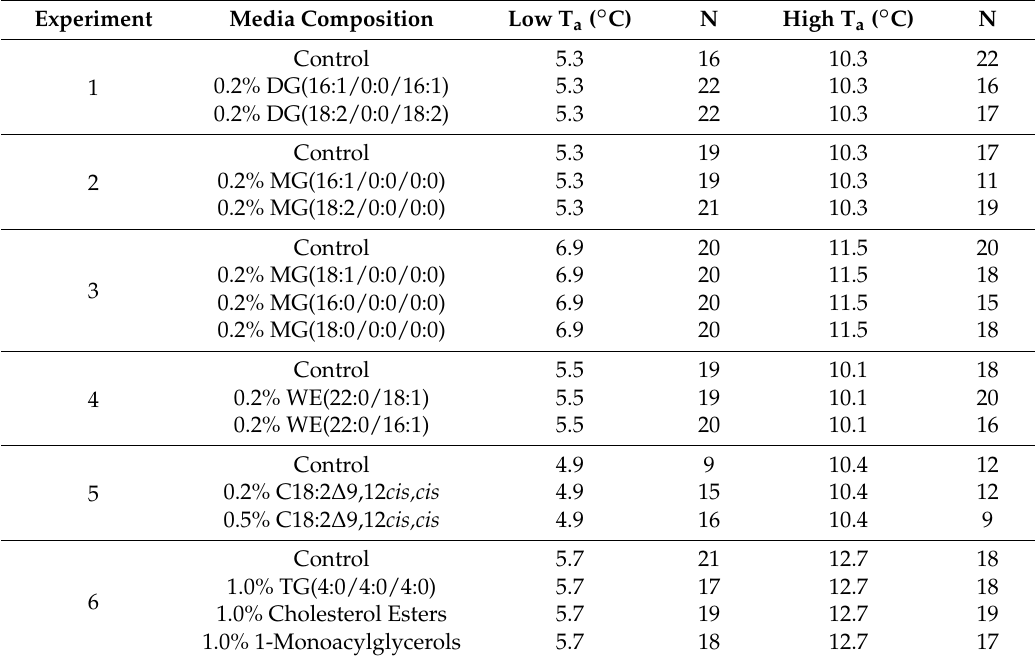
Table 2. Media, ambient temperature (T a ), and sample size (N) for the P. destructans growth experiments. Experiment Media